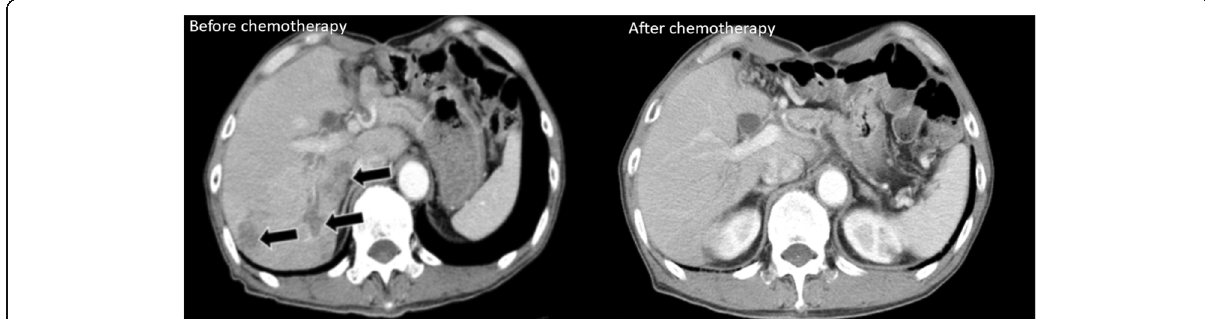
Fig. 3 CT scan images before and after chemotherapy. Abdominal contrast-enhanced computed tomography revealed multiple low-density areas (arrows) 2 months after the second surgery. After 2 courses of chemotherapy, a CT scan revealed absence of all liver metastatic